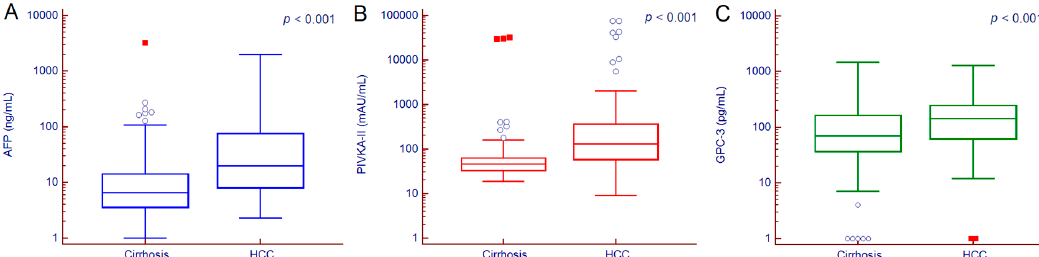
Figure 2. AFP ( A ), PIVKA-II ( B ) and GPC-3 ( C ) serum values in patients with or without HCC. Hollow circles indicate values that are smaller than the lower quartile minus 1.5 times the interquartile range, or larger than the upper quartile plus 1.5 times the interquartile range; red squares indicate values that are smaller than the lower quartile minus 3 times the interquartile range, or larger than the upper quartile plus 3 times the interquartile range. p values were calculated by Man–Whitney test. Abbreviations—alpha-fetoprotein (AFP), glypican-3 (GPC-3), hepatocellular carcinoma (HCC), protein induced by vitamin K absence or antagonist II (PIVKA-II).